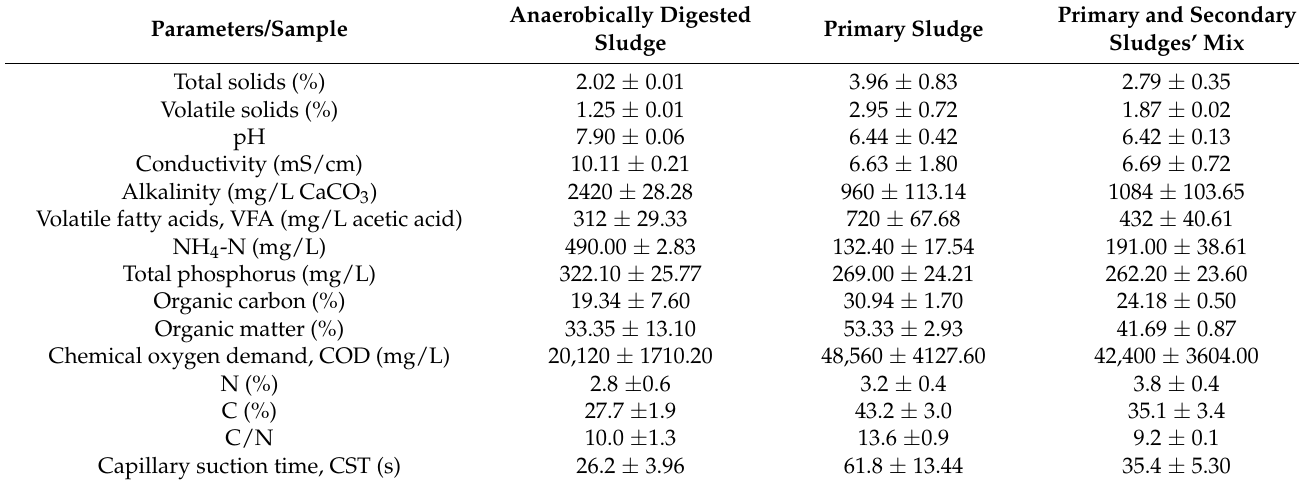
Table 1. Characterization of primary sludge, mix of primary and secondary sludges, and anaerobically digested